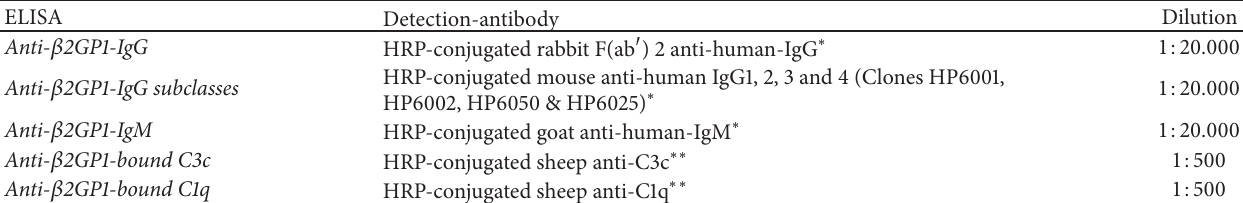
Table 1: Antibodies employed for each